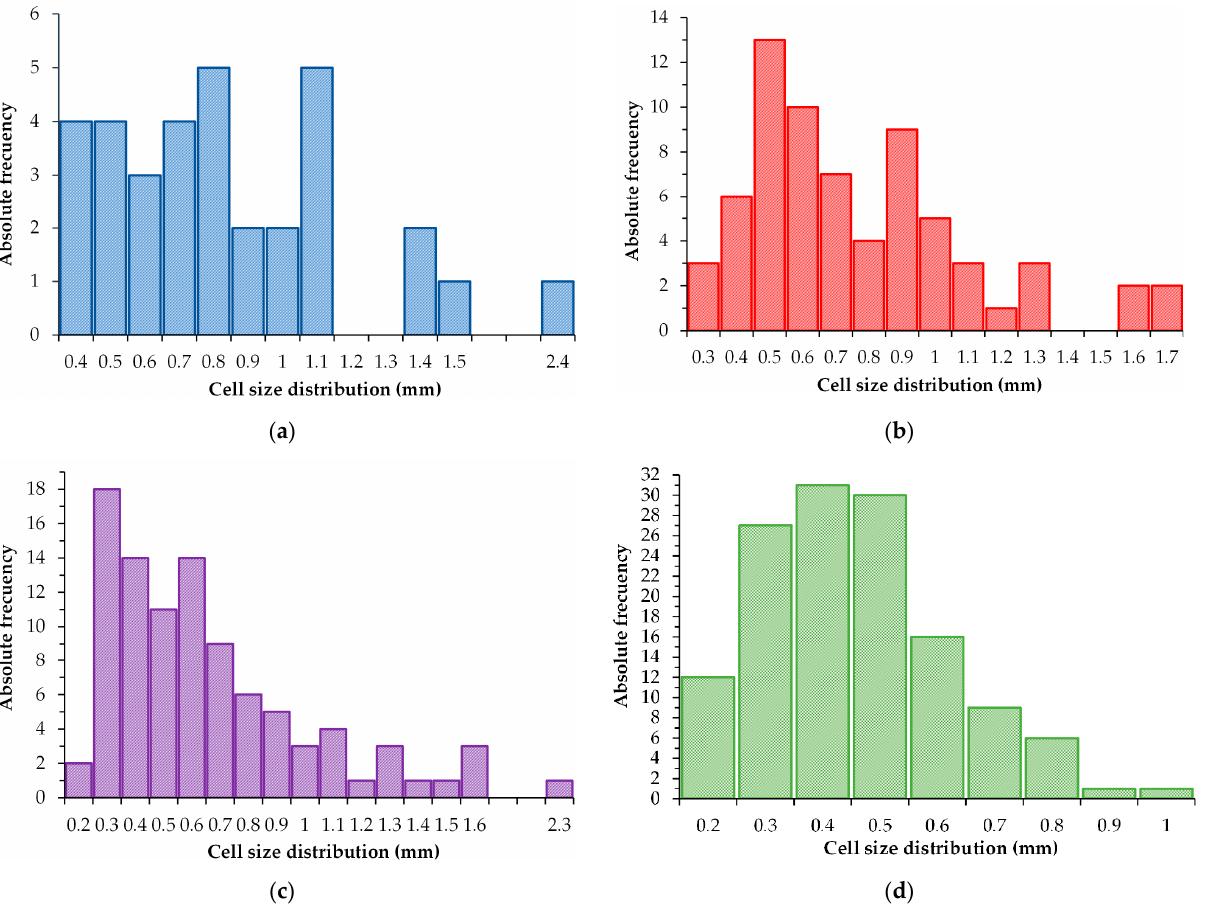
Figure 7. Cell size distribution of aluminum foams of ( a ) Foam 1, ( b ) Foam 2, ( c ) Foam 3, and ( d ) Foam